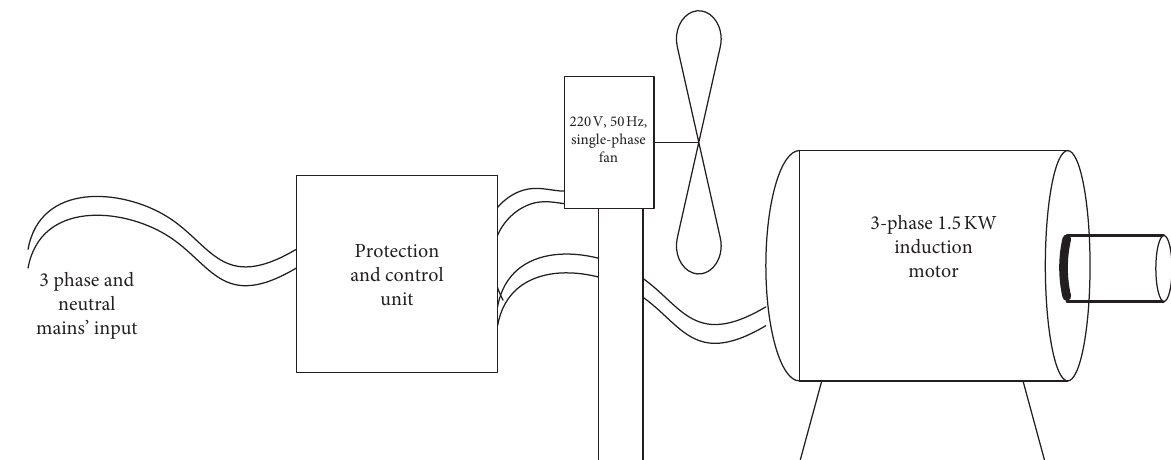
Figure 9: The physical arrangement of the control unit, fan, and induction motor.